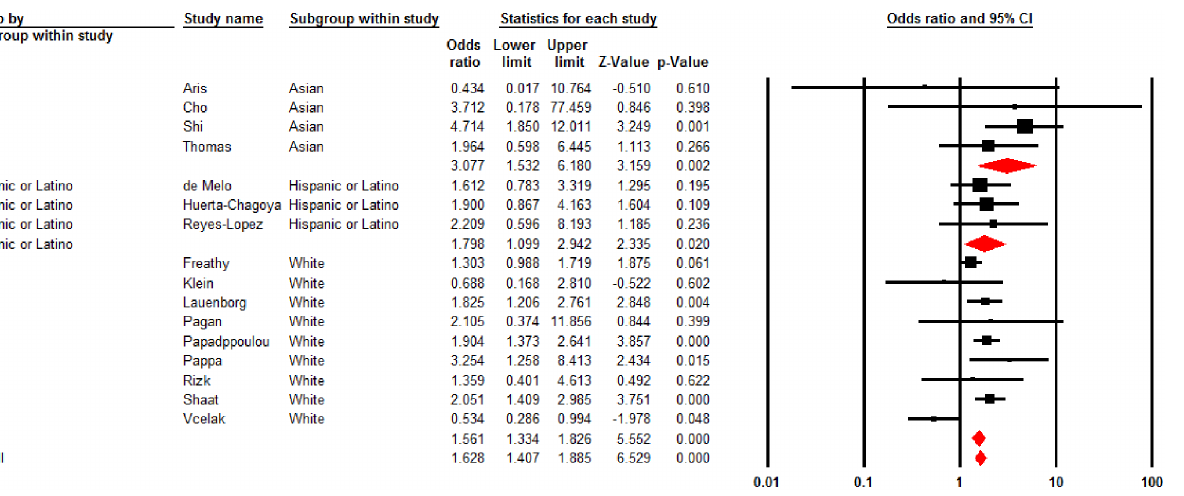
Fig 2. Forest plot of TCF7L2 rs7903146 polymorphism (TT versus CC) and GDM risk under fixed effect model in overall sample and sub-racial groups. The squares and horizontal lines correspond to the study specific odds ratios (ORs) and 95% confidence intervals (CI) respectively. The diamond represents the pooled ORs and 95% CI.